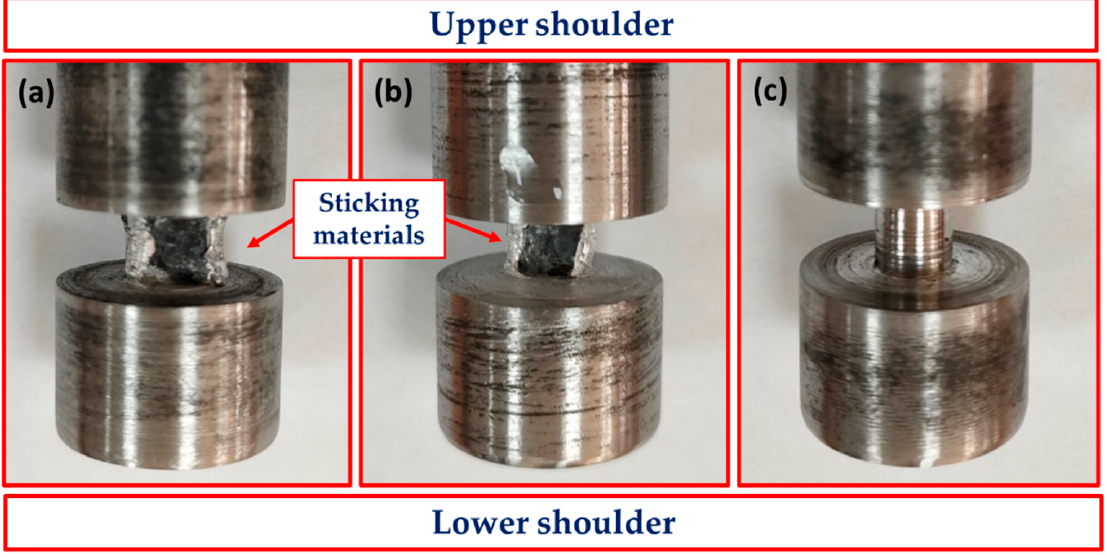
Figure 20. Photo images showing the sticking of plasticized aluminum of the different pin geometries of ( a ) Tr, ( b ) Sq, and ( c ) Cy used in BT-FSP of 8 mm thickness AA1050.